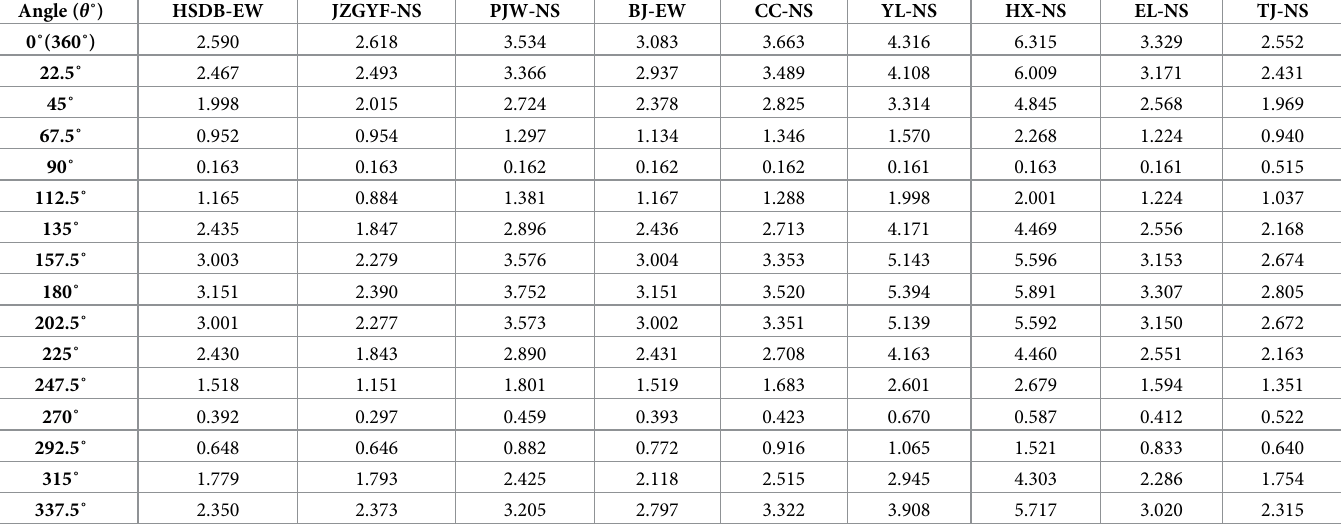
Table 11. The maximum hydrodynamic pressure of the circumferential direction for tank bottom under unidirectional main seismic motion with 1.0 m/s 2 peak acceleration for A-50% condition (KPa). Angle ( θ ˚) HSDB-EW